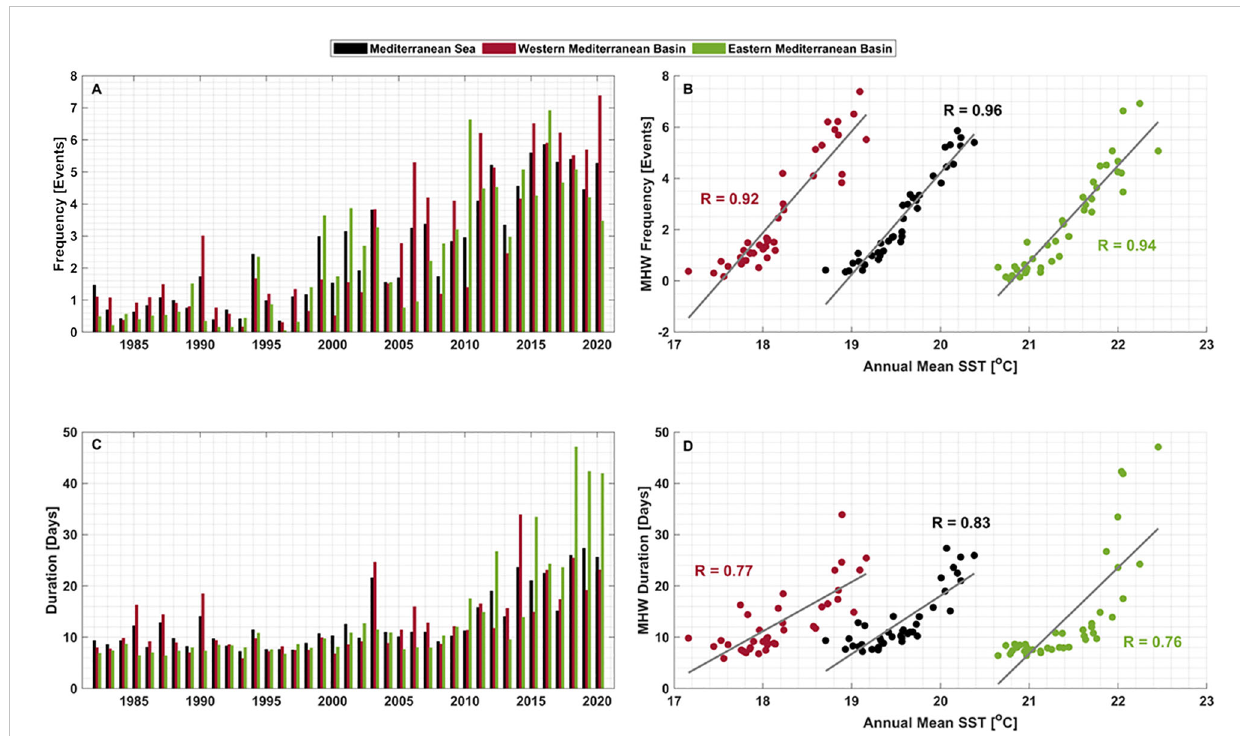
FIGURE 3 Interannual variability of MHW metrics, (A) annual mean MHW frequency (events/year), (B) scatterplots of annual mean SST versus annual mean MHW frequency, (C) annual mean MHW duration (days/year), and (D) scatterplots of annual mean SST versus annual mean MHW duration. The colors black, red, and green represent the entire Mediterranean Sea, the WMB, and the EMB,